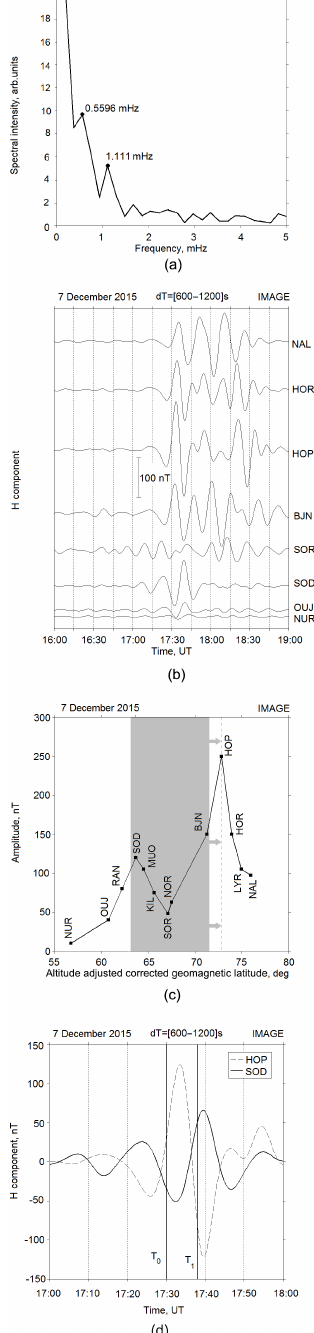
Figure 9. Wave portrait of polar substorms: (a) power spectrum of variations in H component at BJN, where the onset begins (see Fig. 2a); (b) variations of H component in a band of 15 ± 5min at IMAGE stations located along the meridian (the presumable width of the auroral oval is indicated in gray); (c) latitudinal (along- meridian) distribution of pulsation intensity; and (d) out-of-phase variations at the SOD and HOP stations, where the latitudinal dis- tribution of pulsation intensity has its maxima. Open arrows show the time of the enhancement of prebreakup arcs. T 0 and T 1 are the times of onset and torch formation,